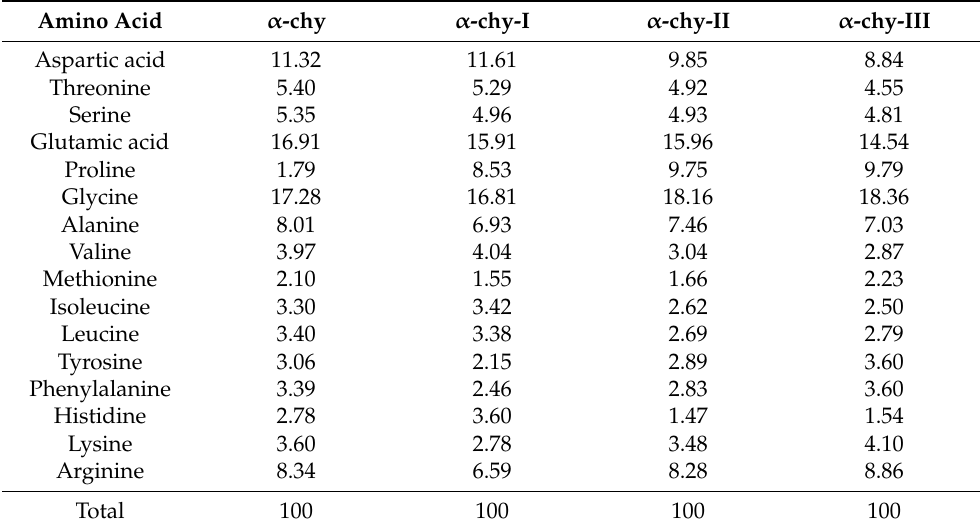
Table 3. Amino acid distribution in α -chy and its UF